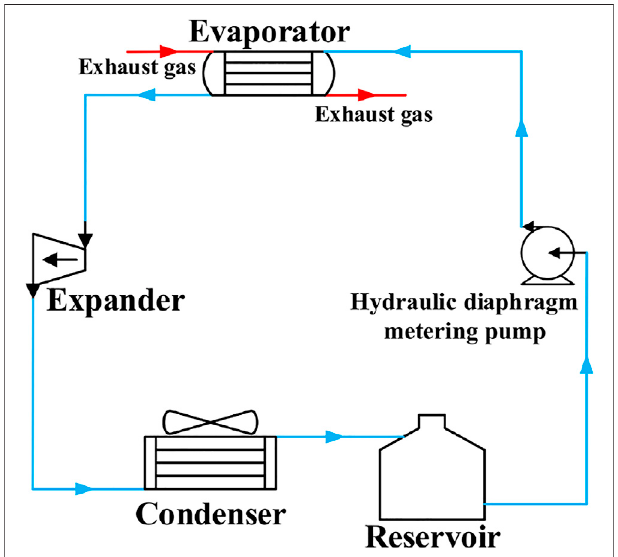
FIGURE 1 | Schematic representation of the ORC system.